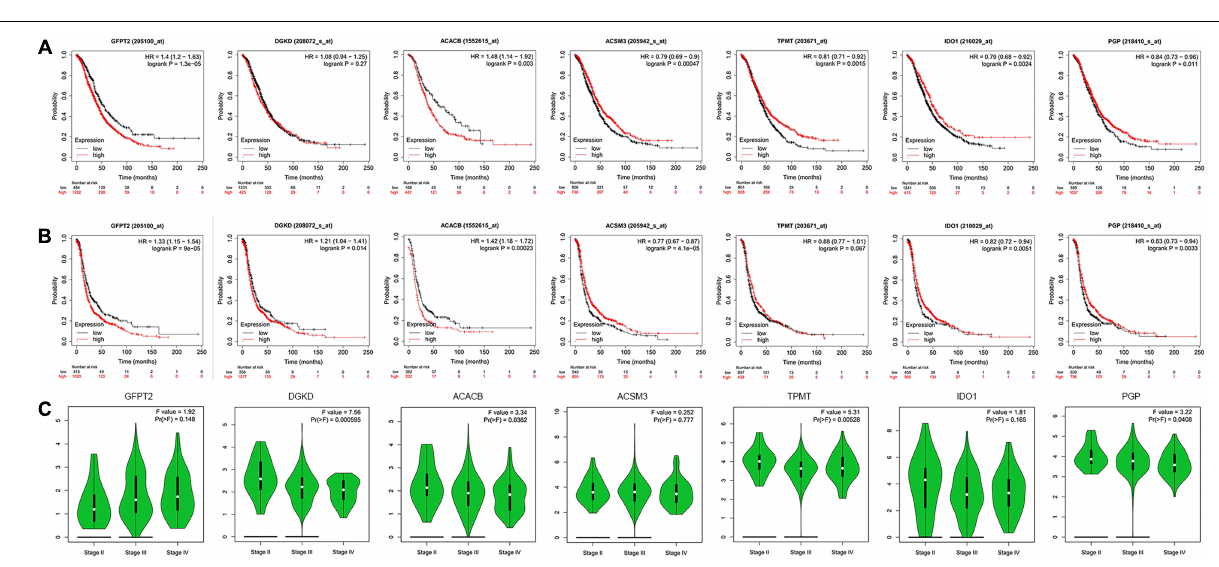
FIGURE 3 | Analysis of hub genes with clinical data. (A) Kaplan-Meier curve analysis of OS comparing the high and low levels of seven metabolism-related genes. (B) Kaplan-Meier curve analysis of PFS comparing the high and low expression levels of seven metabolism-related genes. (C) The violin pot shows the correlations with the clinical stage. Red, high expression; Blue, low